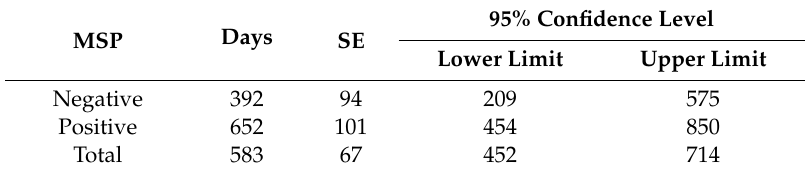
Figure 2. Kaplan–Meier plot for pancreatic cancer postoperative survival stratified by methylation-specific PCR (MSP) results concerning the status of ZNF154 methylation ( n = 80, p = 0.004). Table 2. Logrank test analysis results for median postoperative survival (days) according to Table 3. Clinical parameters and their respective strength of association for survival in our patient collective (MSP = methylation-specific PCR).